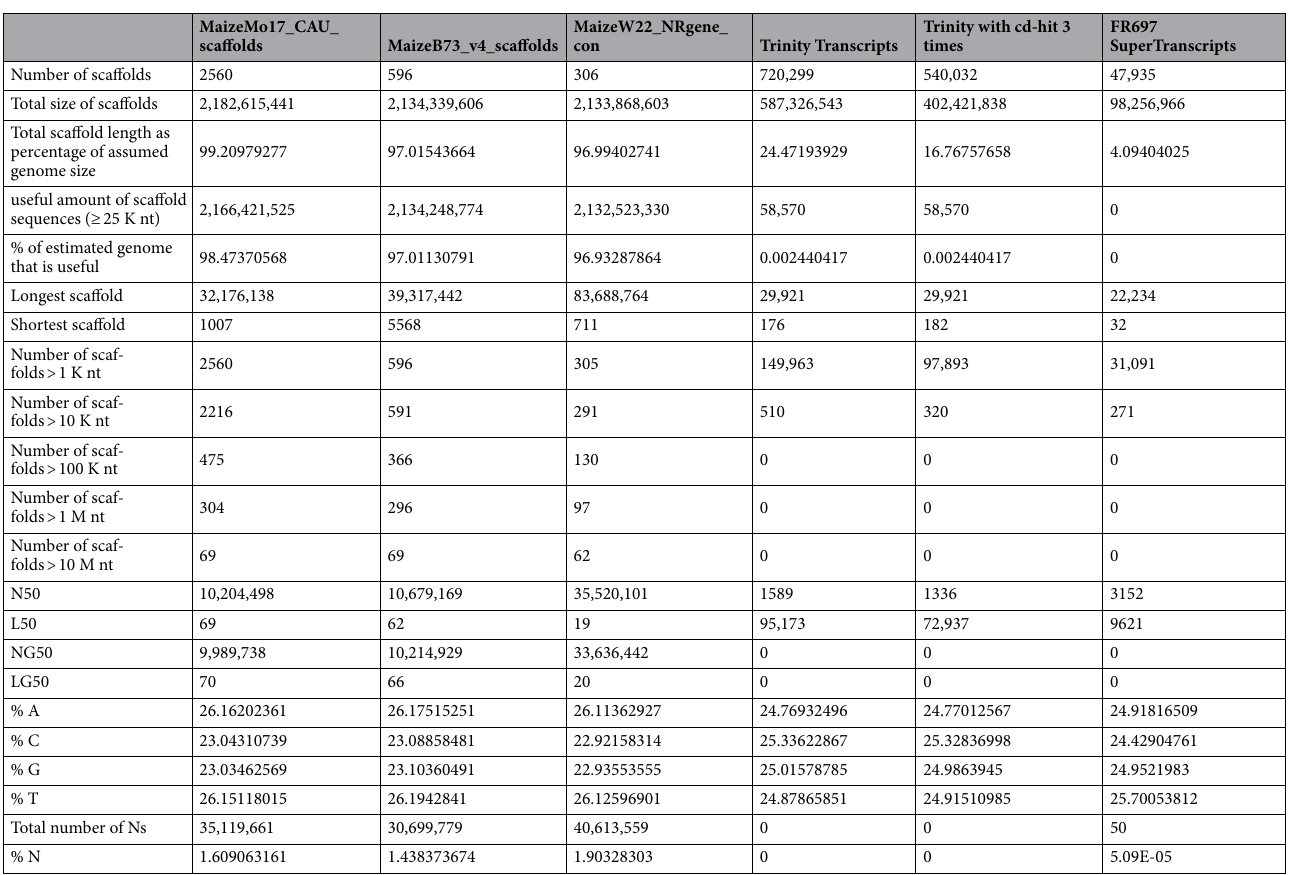
Table 1. Various metrics for the FR697 SuperTranscriptome compared to three maize reference genotypes and the improvement of annotation over the initial trinity assembly. N50: sequence length of the shortest contig at 50% of the assembly size; L50: Number of contigs/scaffold whose length sum equals half of genome size; NG50: sequence length of the shortest contig at 50% of the full genome assembly length—not calculated for transcriptome assembly; LG50: Number of contigs/scaffold whose length sum equals half of whole genome assembly length -also not calculated for transcriptome